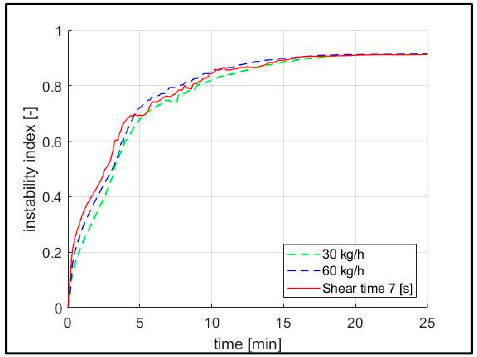
Figure 7. Instability index of the two laboratory emulsions and the reproduction emulsion with a shear time of 7 s.